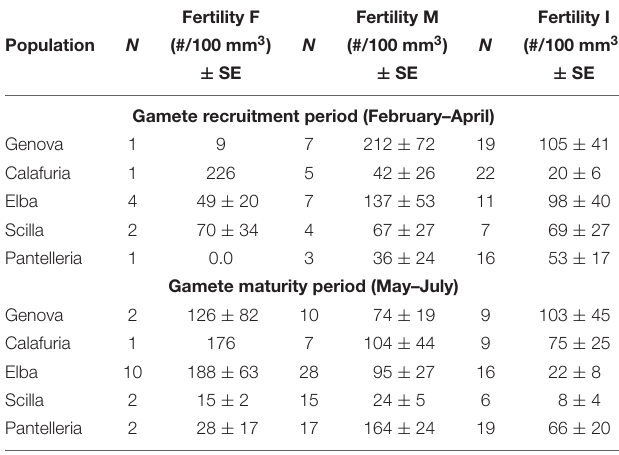
TABLE 3 | Mean fecundity, gonadal index and diameter of oocytes in each population for gamete recruitment and gamete maturity periods. Fecundity Gonadal Oocytes